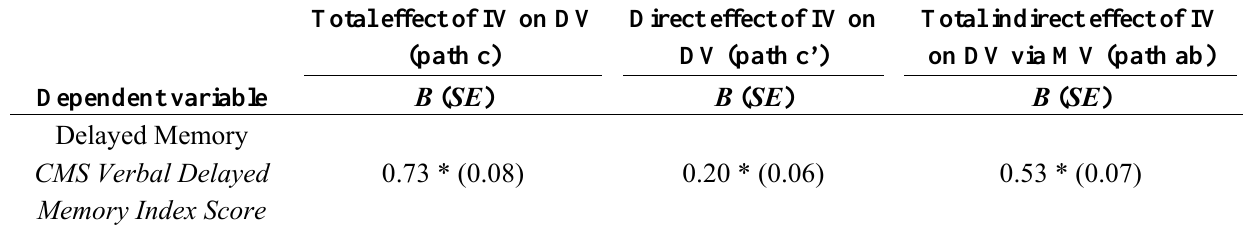
Table 6. Total and direct effect of verbal knowledge on verbal delayed memory, and the total indirect effect of verbal knowledge on verbal delayed memory via verbal immediate